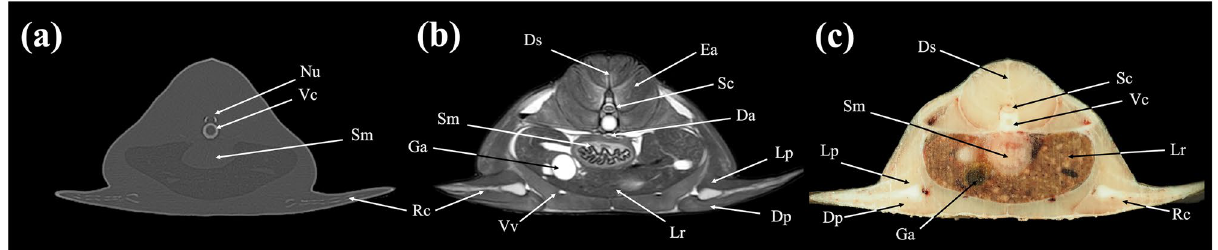
Figure 7. Transverse ( a ) CT, ( b ) MR, and ( c ) cryosection images of a banded houndshark ( Triakis scyllium ) at level 7 of Fig. 25. Da Dorsal aorta, Dp Depressor pectoralis, Ds Dorsal median septum, Ea Epaxial, Ga Gall bladder, Ha Hypaxial, Lp Levator pectoralis internus, Nu Neural arch, Lr Liver, Rc Radial cartilage, Sc Spinal cord, Sm Stomach, Vc Vertebral centrum, Vv Ventral abdominal vein.